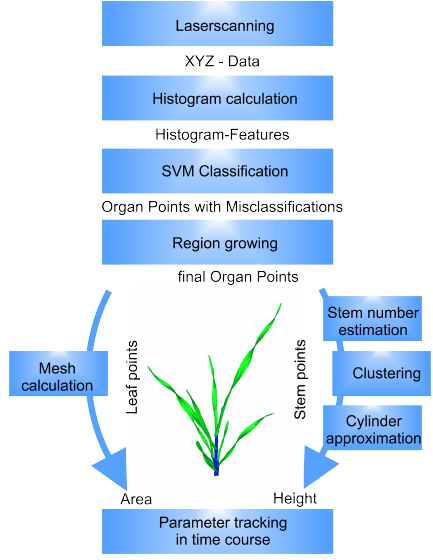
Figure 1. Data flow for the parameterization of the barley plant point cloud. The laser scanner provided XYZ point clouds that were classified, refined by a region growing algorithm and parameterized due to their organ type. This enabled parameter tracking